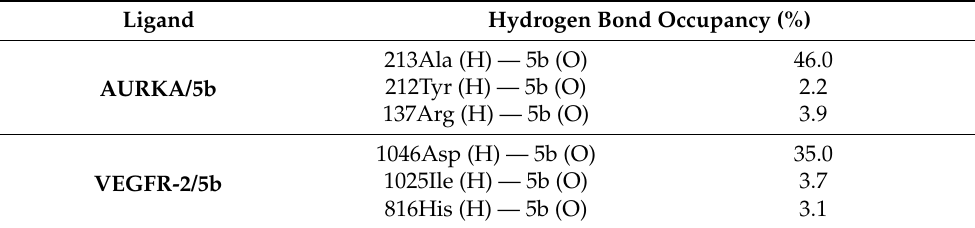
Table 5. Hydrogen bond occupancy between the ligand and the amino acid residues at the protein- binding